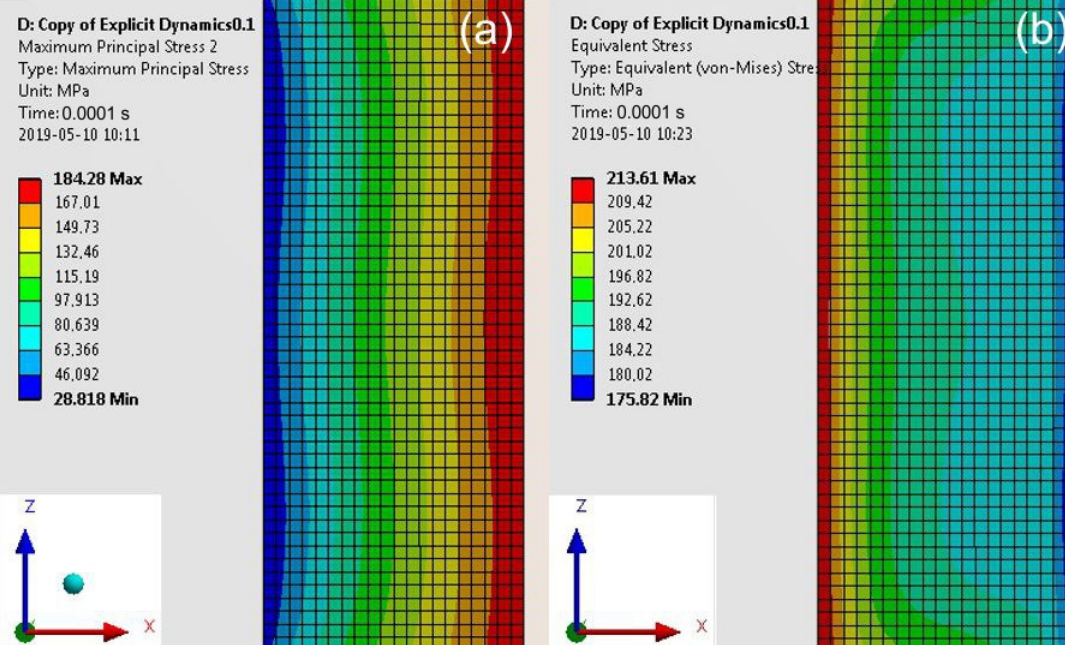
Figure 12. Map of the Main Principal Stress ( a ) and the von Mises Stress ( b ) in the adhesive layer for a computation time equal to 0.0001 s—Model no. 1 (linear analysis). The loads are applied in the direction of the X axis.